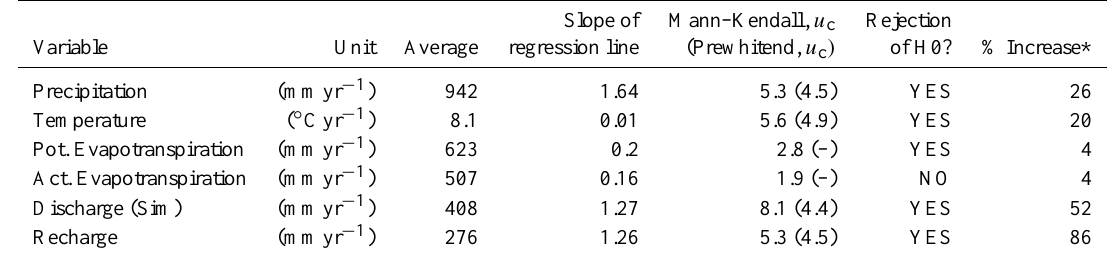
Fig. 4. Comparison of precipitation versions: the raw data, the SNHT adjusted, and the SNHT adjusted and corrected for wetting and aerodynamic effects. The increase values give the percentage increase over 100yr. Table 4. Regression statistics of observed time series of precipitation, temperature, and evapotranspiration. Also shown are the statistics on the outputs from the NAM model including actual evapotranspiration, stream discharge and groundwater